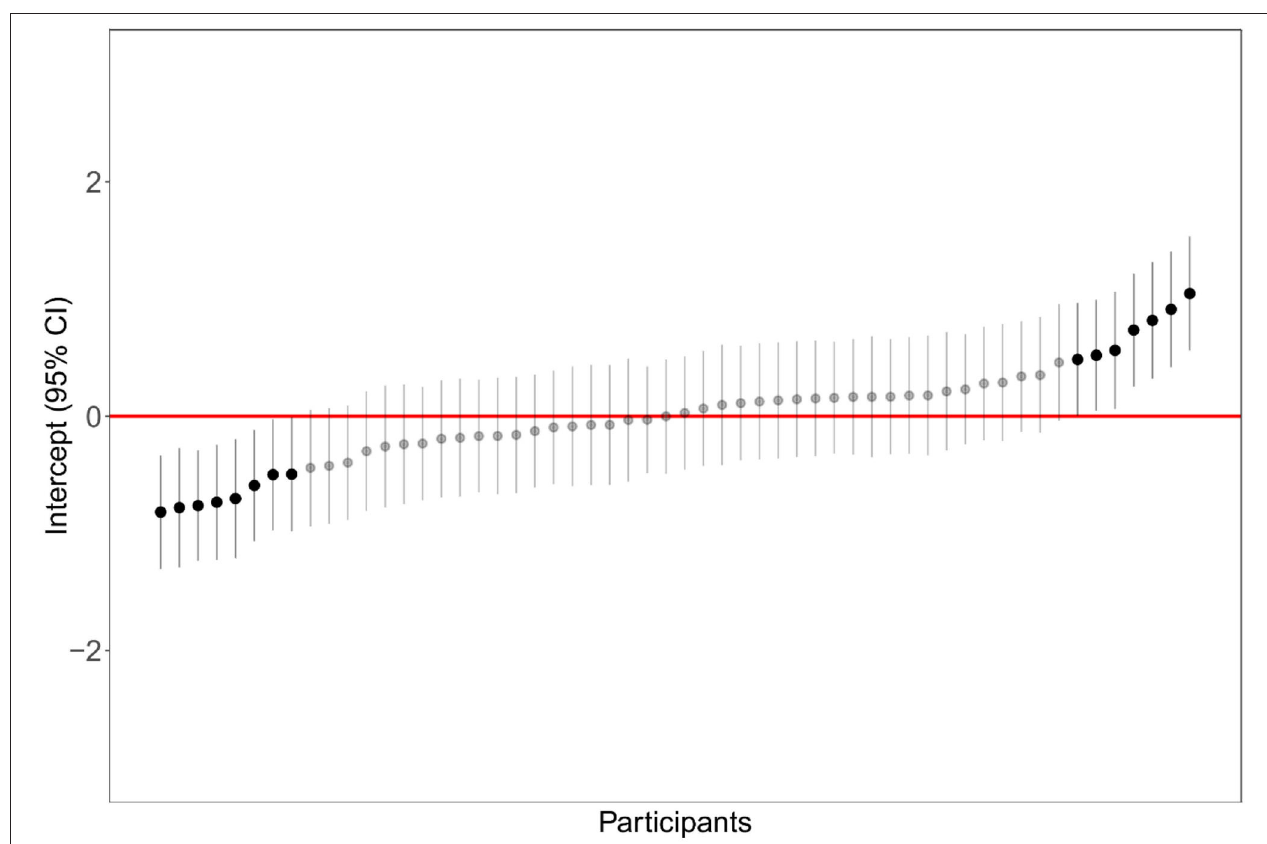
FIGURE 4 | Distribution of participants’ intercept (random effect) in the linear mixed model examining landscape preference as a function of aggregation type.